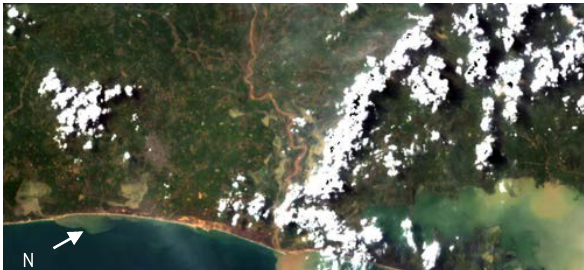
Figure 4. Subset of HICO scene acquired on 16 October 2013 in response to IDC activation for flooding in India following Tropical Cyclone Phailin.